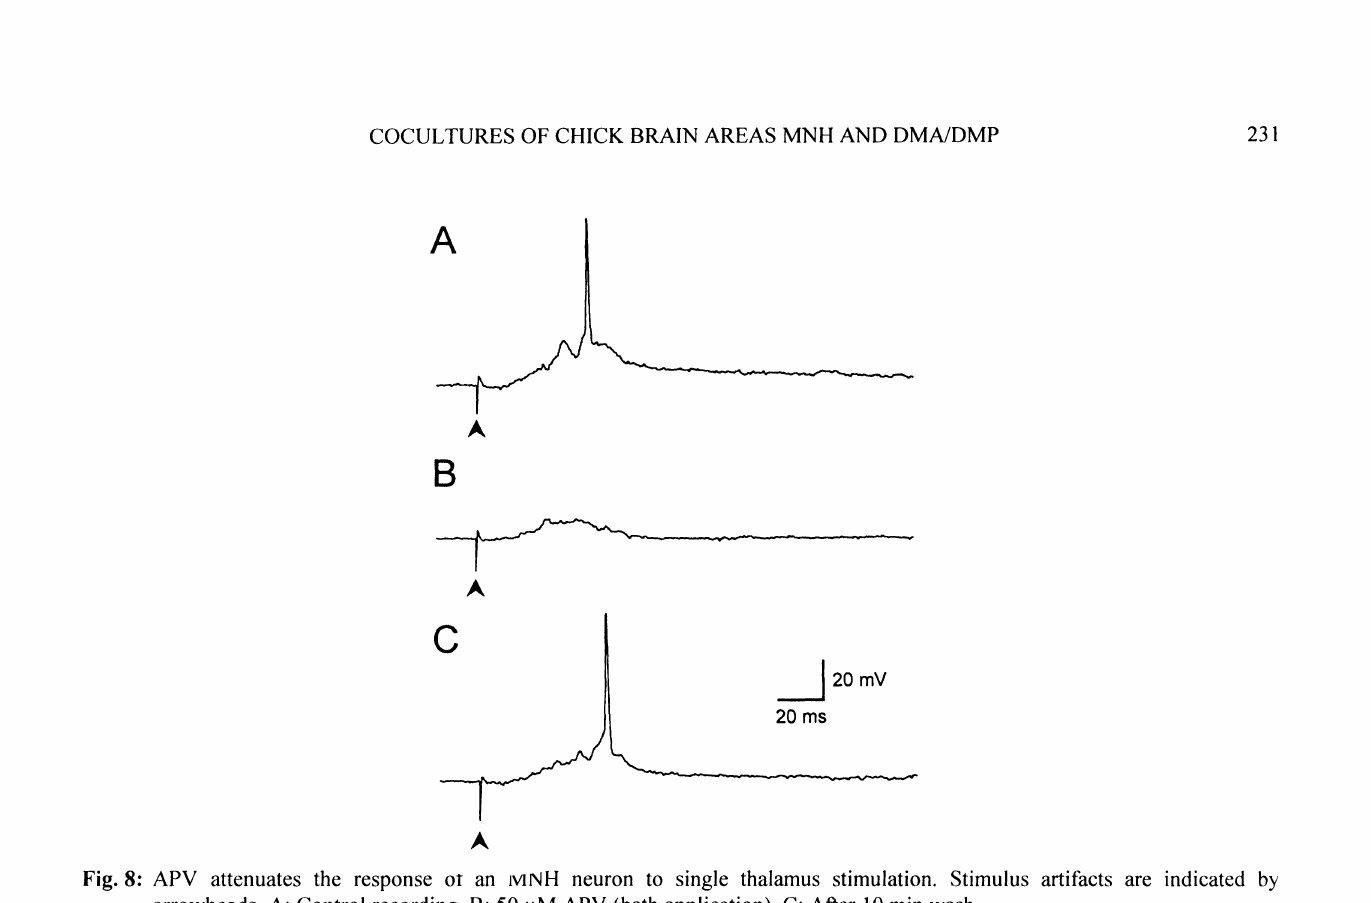
Fig. 8" APV attenuates the response o an MNH neuron to single thalamus stimulation. Stimulus artifacts are indicated by arrowheads. A’ Control recording. B" 50 tM APV (bath application). C: After 10 min wash.